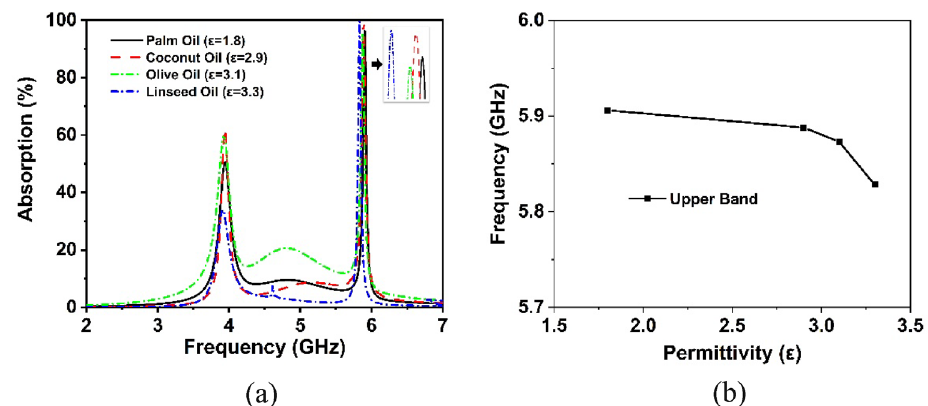
Figure 26. ( a ) Absorption properties of various liquid (Edible oil) materials sensing and ( b ) plot of dielectric constant against frequency at the point of maximum